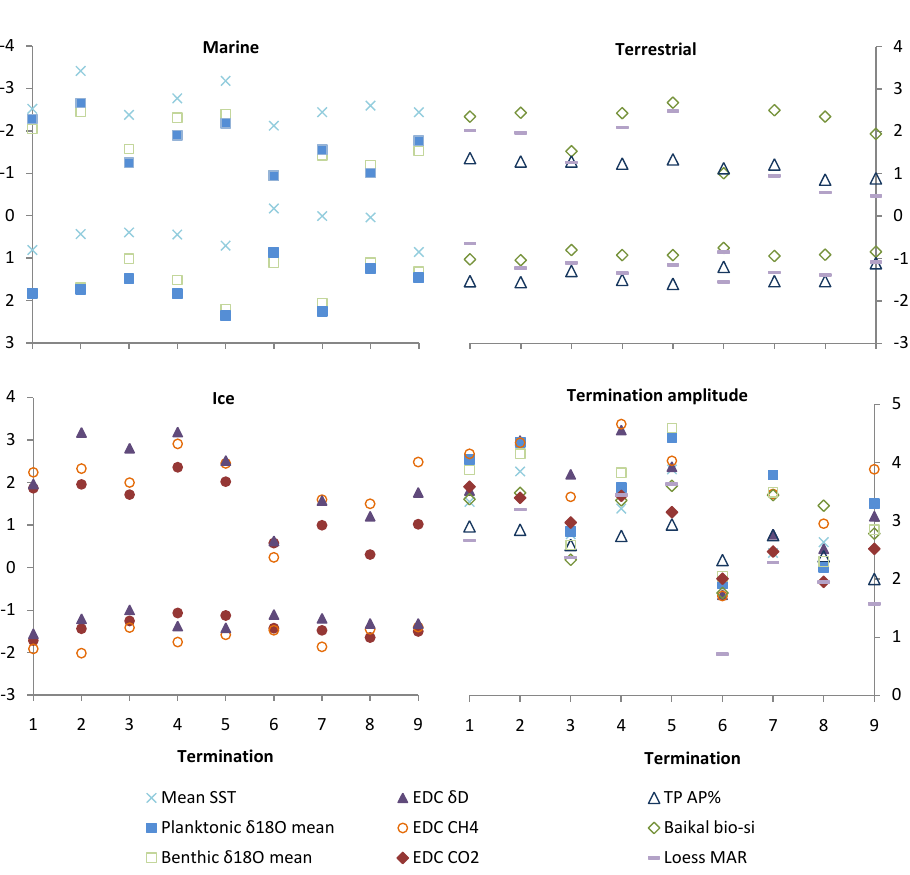
Fig. 4. Normalised peak values for each termination showing interglacial (upper series) and glacial maxima (lower series) and nor- malised termination amplitude. Each record’s interglacial/glacial/termination amplitude values were normalised to the mean inter- glacial/glacial/termination amplitude value for that